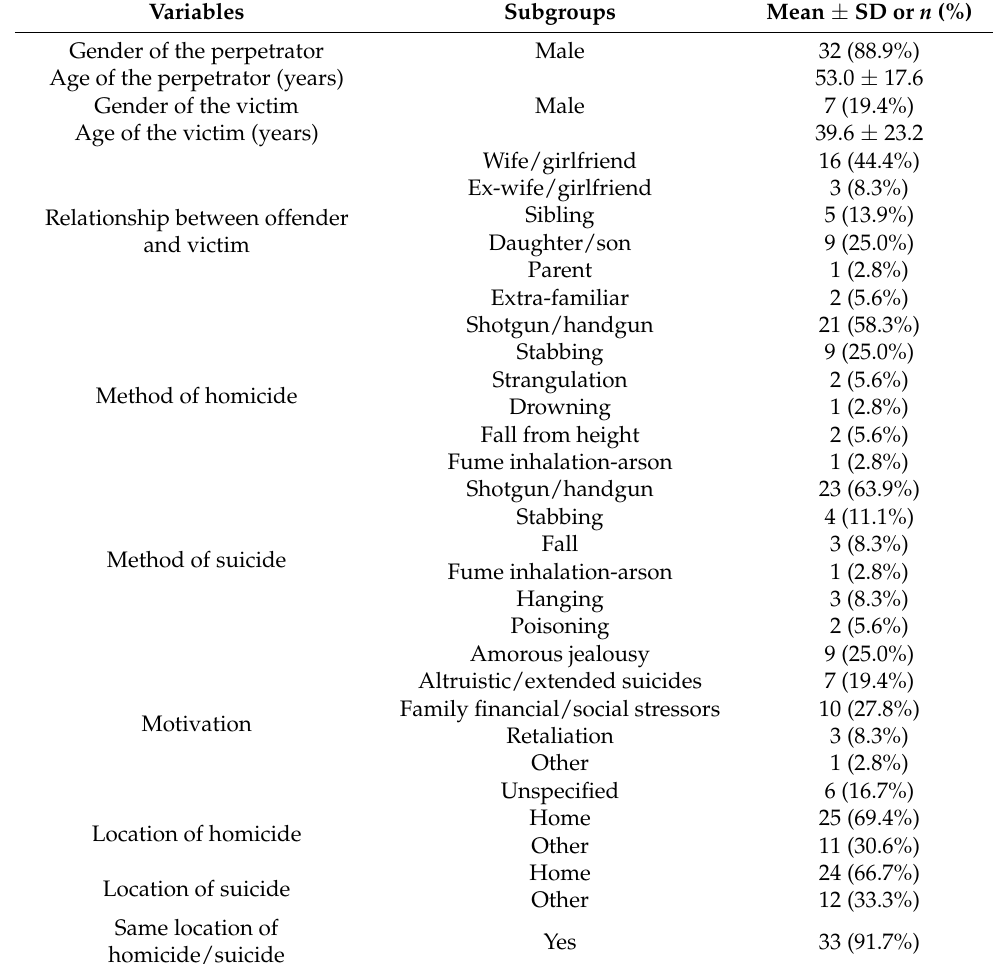
Table 1. Sociodemographic characteristics of the study sample ( n =